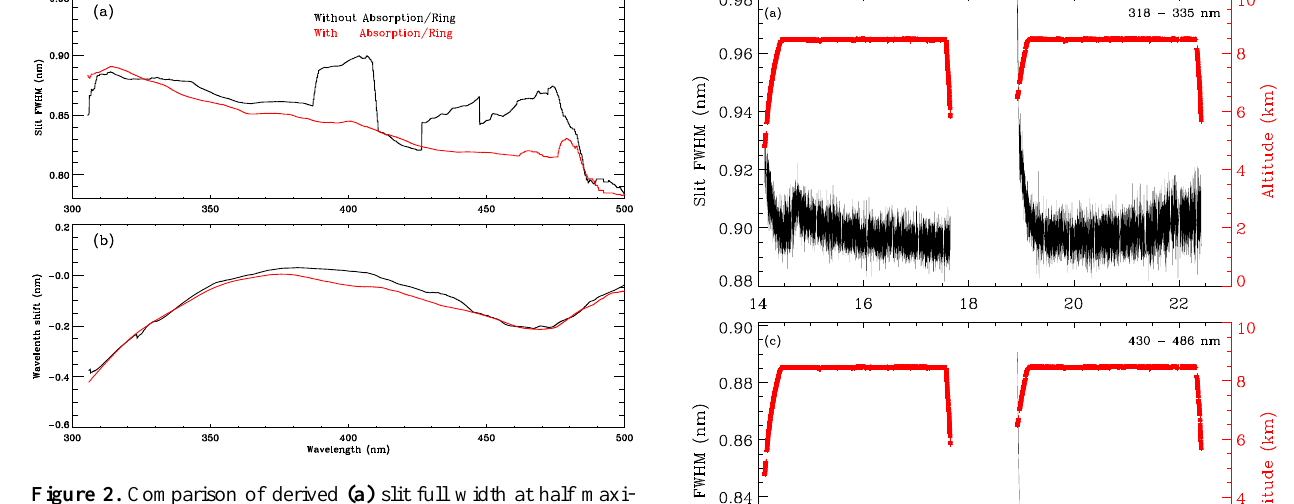
Figure 2. Comparison of derived (a) slit full width at half maxi- mum (FWHM) and (b) wavelength shift as functions of wavelength for the ACAM air-quality channel (304–500nm), with and without accounting for the absorption and ring effect, for a pixel from 21 July 2011. The slit functions and wavelength shifts are derived over a range of 201 ACAM pixels ( ∼ 20nm) in 3-pixel increments slid- ing through the channel. The derived slit and wavelength parameters at a wavelength are the average of the corresponding parameters in all windows including this wavelength.